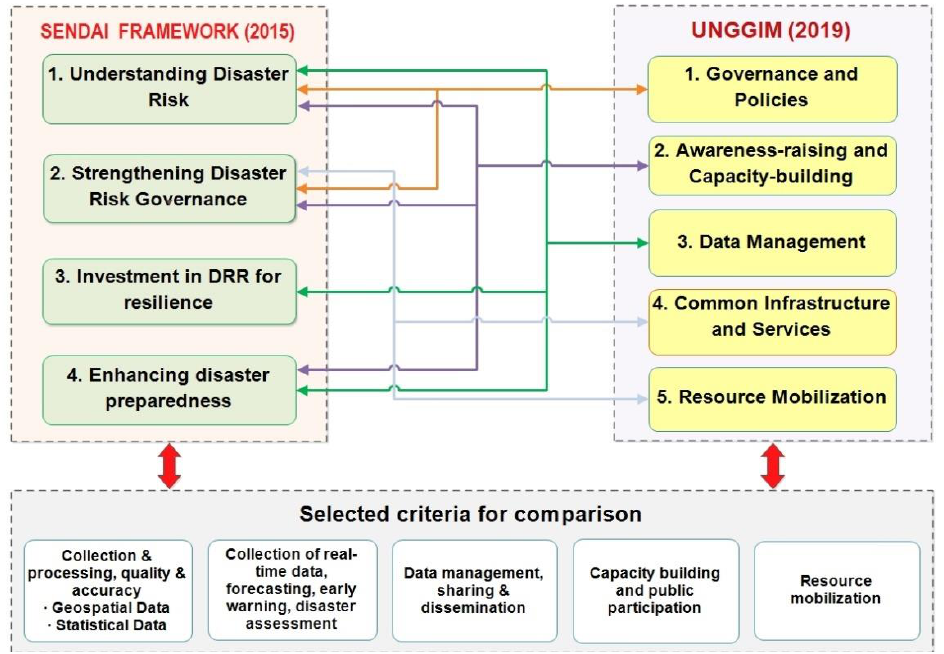
Figure 1. The linked priorities of the two frameworks based on recommended national and local level interventions regarding spatial data.